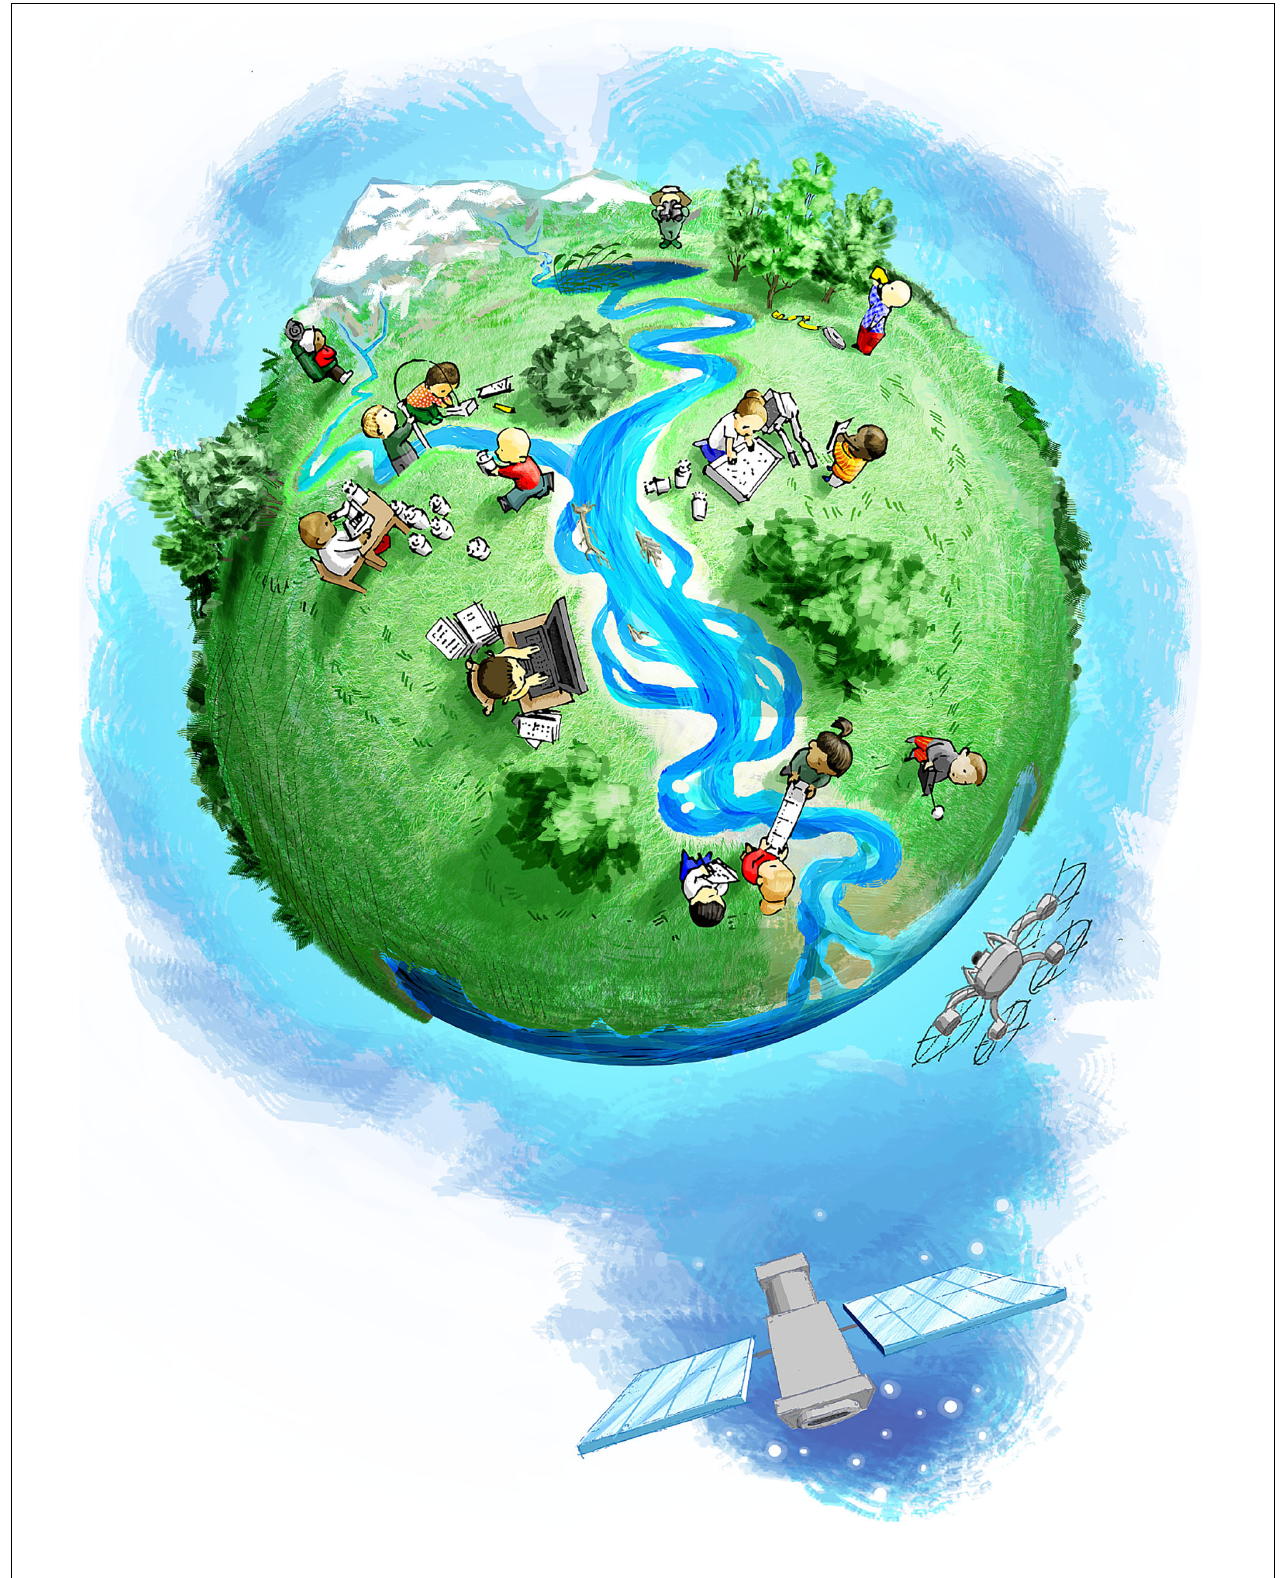
FIGURE 1 | Graphical concept of questions in river science being addressed collaboratively by international interdisciplinary teams of scientists.